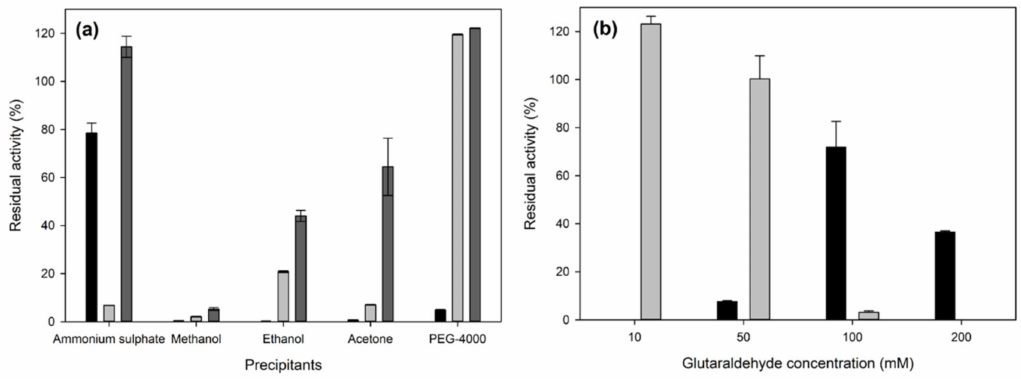
Figure 2. ( a ) E ff ect of precipitants on the formation of CLEAs. Glutaraldehyde was added as a crosslinker at a final concentration of 100 mM. Black bars: CLEAs, light grey bars: residual free enzymes, and dark grey bars: enzyme activity after precipitation and reconstitution (without the crosslinking step). ( b ) E ff ect of glutaraldehyde concentration on the formation of CLEAs. Saturated ammonium sulfate was used as the precipitant. Black bars: CLEAs, and light grey bars: residual free